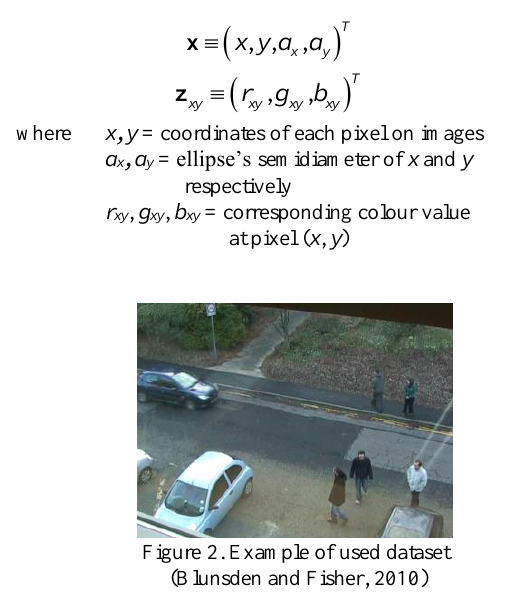
Figure 2. Example of used dataset (Blunsden and Fisher, 2010)